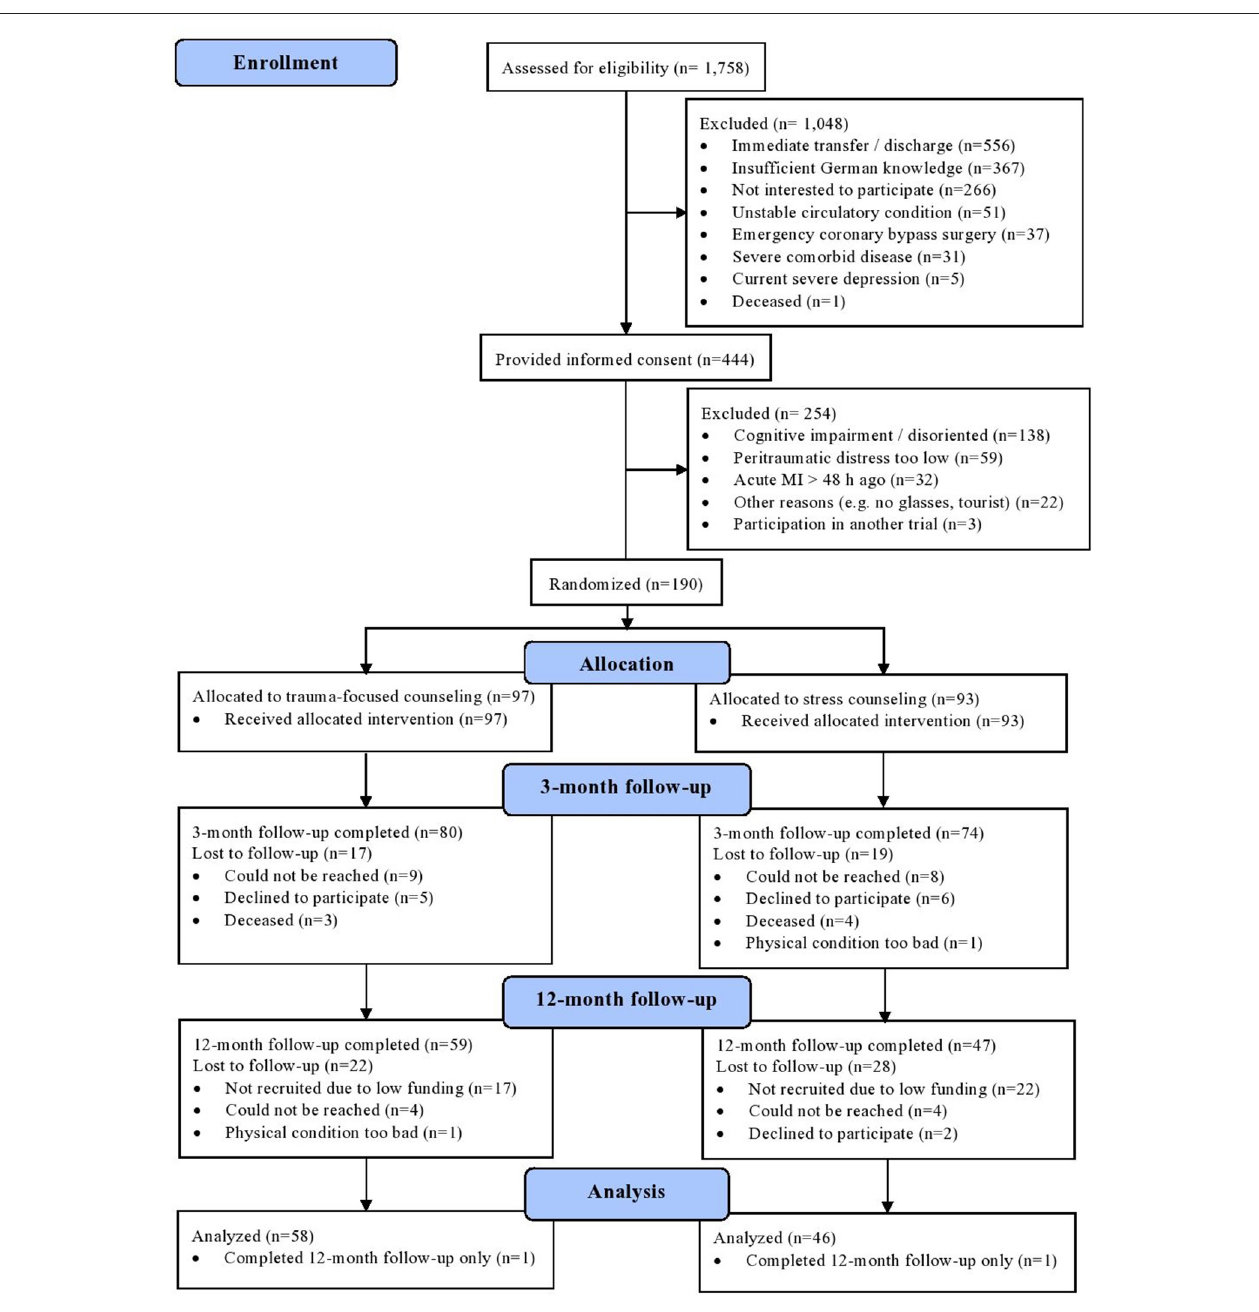
FIGURE 1 | CONSORT flow diagram for the completers ( n = 104) of the MI-SPRINT